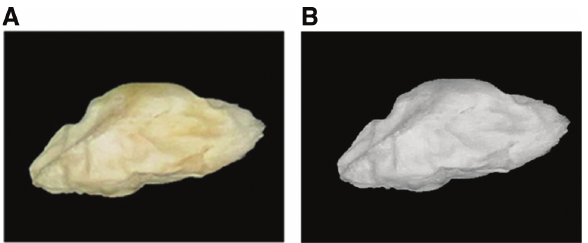
Figure 2: Conversion of a Split Color Image of Wheat Grain Infected with Fusarium to a Gray-Level Image. Image in (A) RGB and (B) gray image.